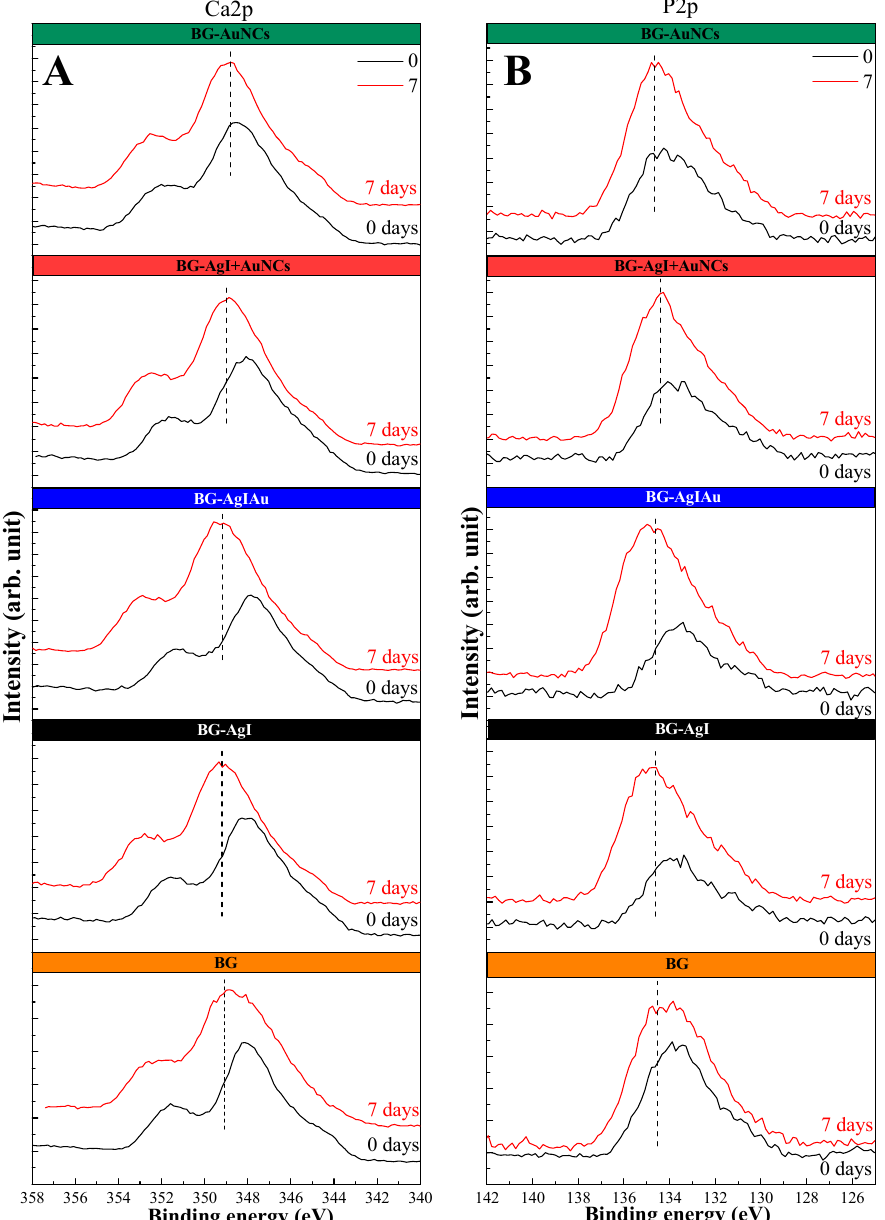
Figure 8. XPS core level spectra for Ca2p ( a ) and P2p ( b ) in BG composites.